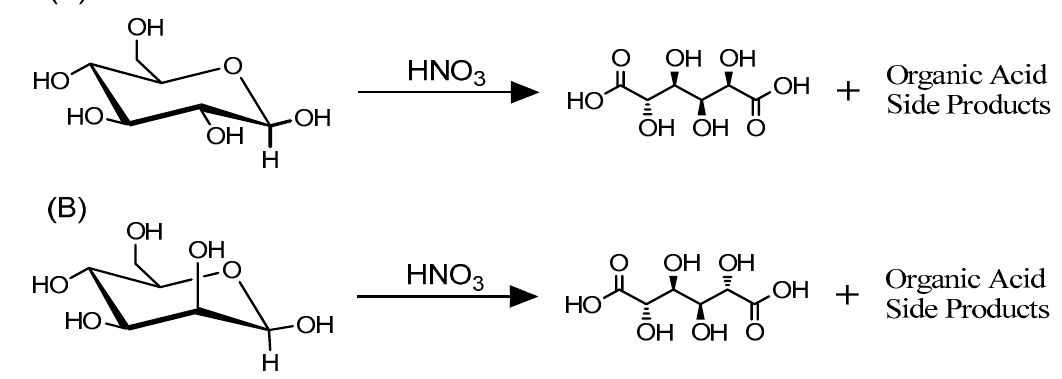
Figure 6. The nitric oxidation of ( A ) d -glucose and ( B ) d -mannose [67,69].